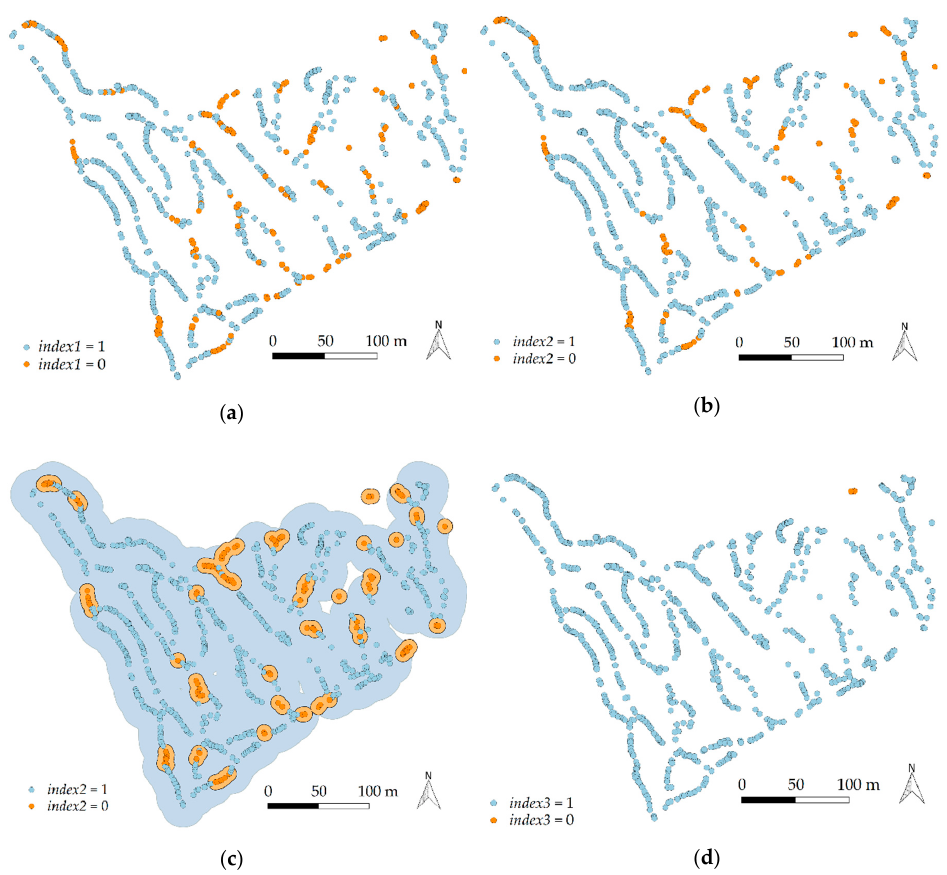
Figure A3. An example of averaged data points in stand recognition in Algorithm A1. The data is from thinning cut object harvested by a machine with a more accurate GNSS. The ETRS-TM35FIN (EPSG:3067) coordinate system is used. ( a ) The stand indices index1 after Stage B.1. of Algorithm A1. ( b ) The locally averaged stand indices index2 after Stage B.2. of Algorithm A1. ( c ) The stand motifs have been merged and buffered (blue), and the overlapping buffered strip road motifs have been merged (orange), both based on index2 . The purpose is to find, using the intersection of buffer areas, which bu ff ered strip roads are either within stand, spur trails or external strip roads leading to stands. ( d ) The result of Algorithm A1: tree points have been classified into two categories, stand and external strip